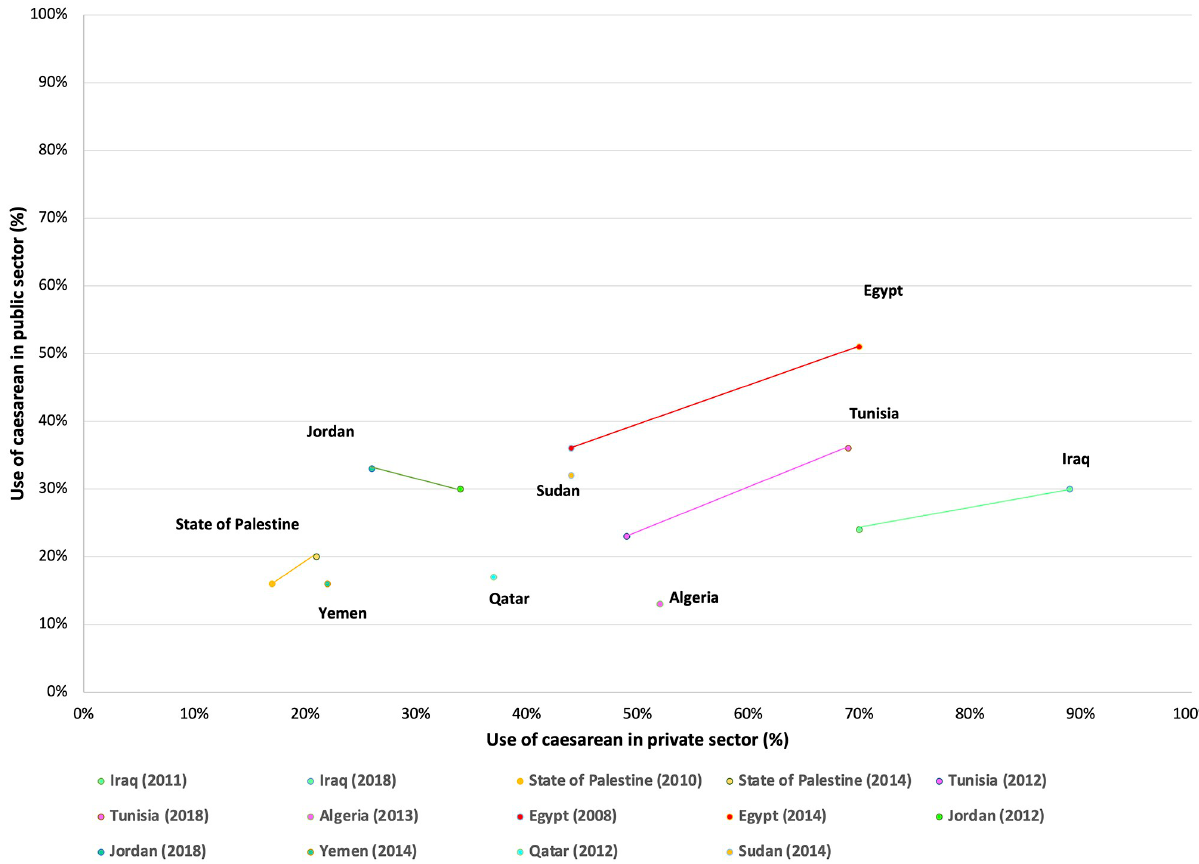
Fig 3. The use of caesarean section in private and public sector facilities by country and survey